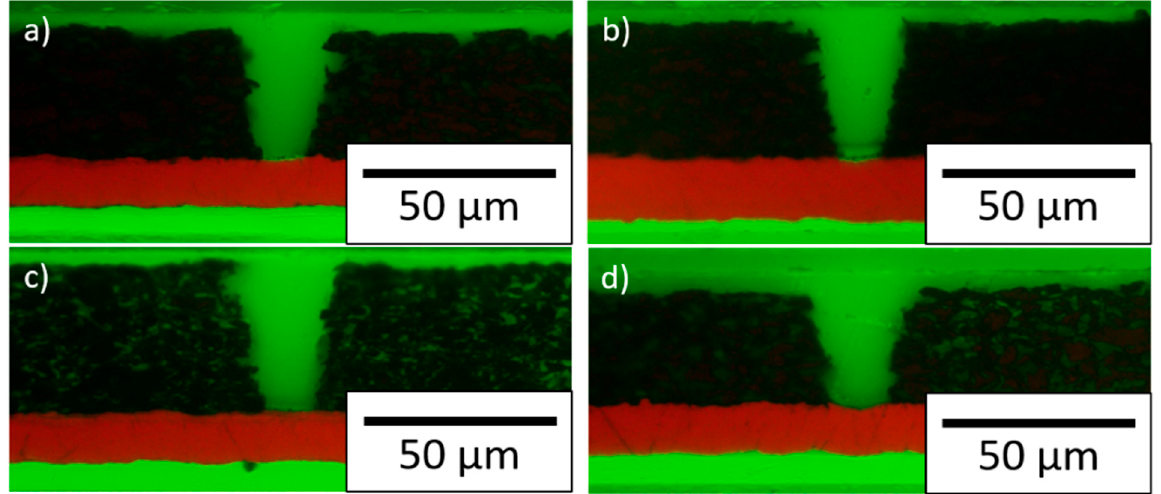
Figure 5. Cross sections of the structured electrodes: ( a ) graphite without silicon, ( b ) graphite with TSi, ( c ) graphite with NGP, and ( d ) graphite with SSN.